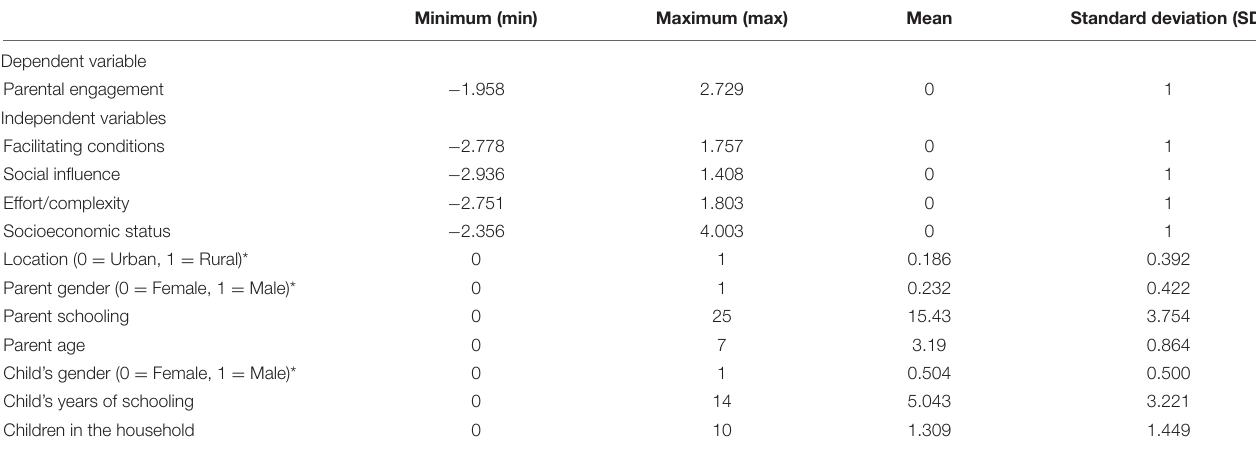
TABLE 4 | Descriptive statistics for the variables used in this study for all countries. Minimum (min) Maximum (max) Mean Standard deviation